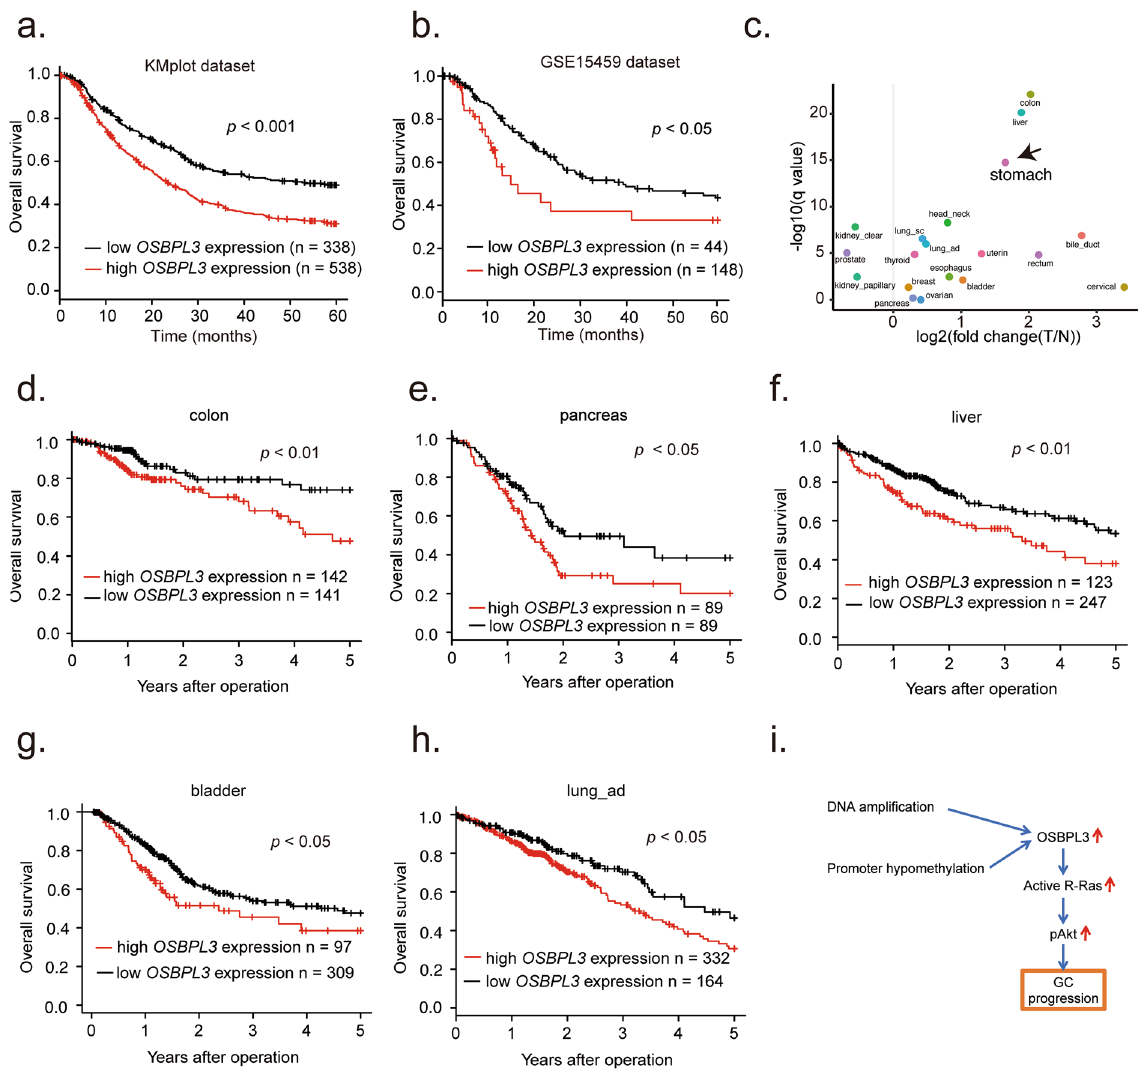
Figure 5. Prognostic significance of OSBPL3 mRNA expression in GC and other solid cancers. ( a ) Kaplan– Meier survival curve of 876 GC patients from a Kmplot dataset based on OSBPL3 mRNA expression. Log-rank test. ( b ) Kaplan–Meier survival curve of 192 GC patients from the GSE15459 dataset based on OSBPL3 mRNA expression. Log-rank test. ( c ) OSBPL3 mRNA expression in tumor tissues compared with normal tissues in patients with various cancers from TCGA. Mann–Whitney U test and FDR-controlling procedures were performed. ( d ) Kaplan–Meier survival curve of 454 colon cancer patients from TCGA based on OSBPL3 mRNA expression. Log-rank test. ( e ) Kaplan–Meier survival curve of 178 pancreatic cancer patients from TCGA based on OSBPL3 mRNA expression. Log-rank test. ( f ) Kaplan–Meier survival curve of 370 liver cancer patients from TCGA based on OSBPL3 mRNA expression. Log-rank test. ( g ) Kaplan–Meier survival curve of 406 bladder cancer patients from TCGA based on OSBPL3 mRNA expression. Log-rank test. ( h ) Kaplan–Meier survival curve of 496 lung adenocarcinoma patients from TCGA based on OSBPL3 mRNA expression. Log-rank test. ( i ) Schematic depicting the mechanisms by which OSBPL3 promotes GC